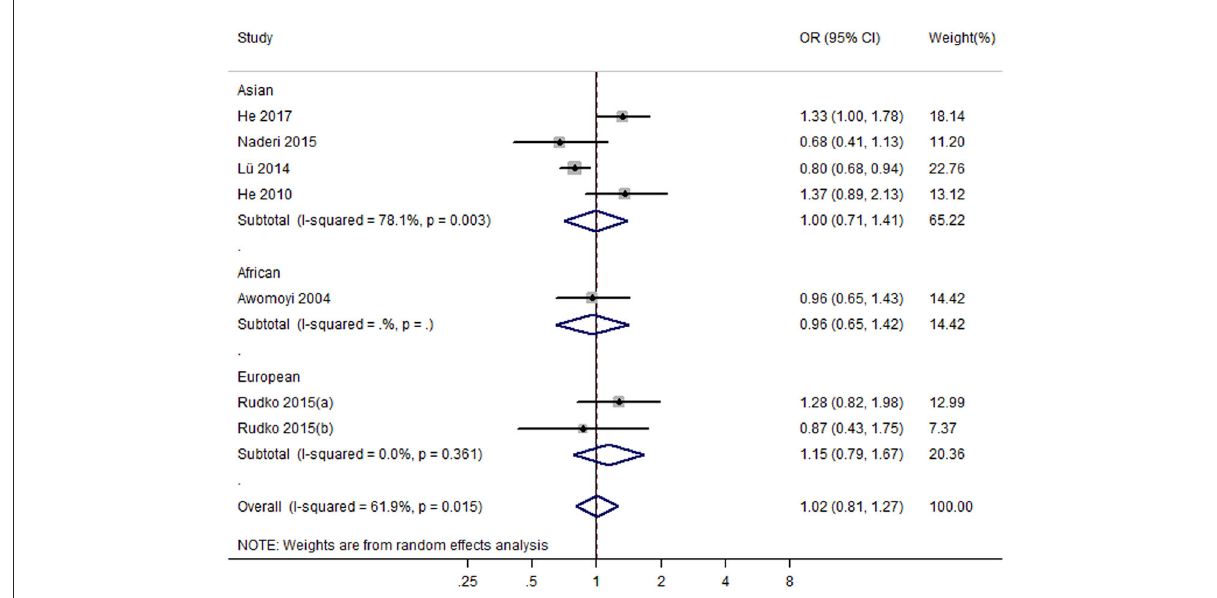
FIGURE4 Forest plot of association between IFNGR1 rs7749390 polymorphism and tuberculosis susceptibility (dominant model: TT + TC vs. CC).